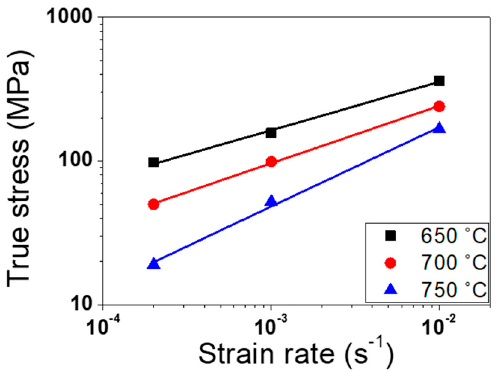
Figure 7. Variation of flow stress as a function of strain rate for STEP-0 specimens.